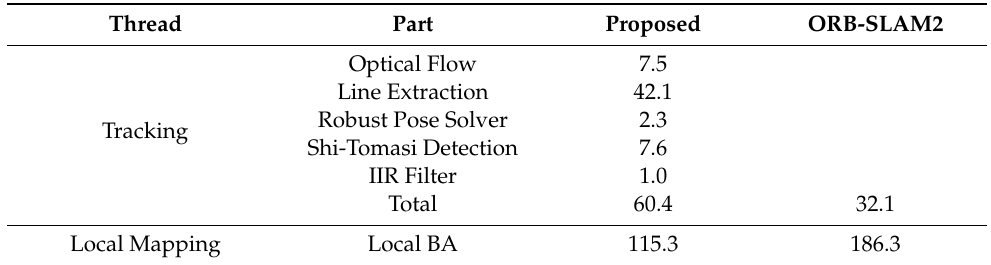
Table 4. Processing time (ms) of each part of the proposed system and comparison with ORB